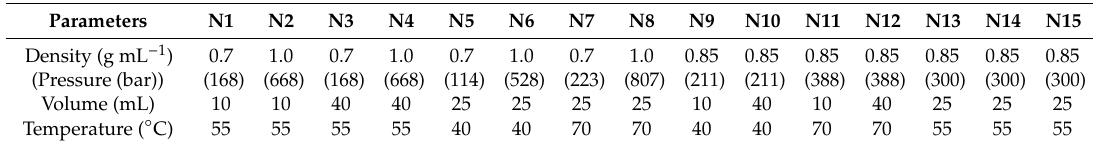
Table 1. Surface response Box–Behnken experimental design of variables for optimization of SFE method.